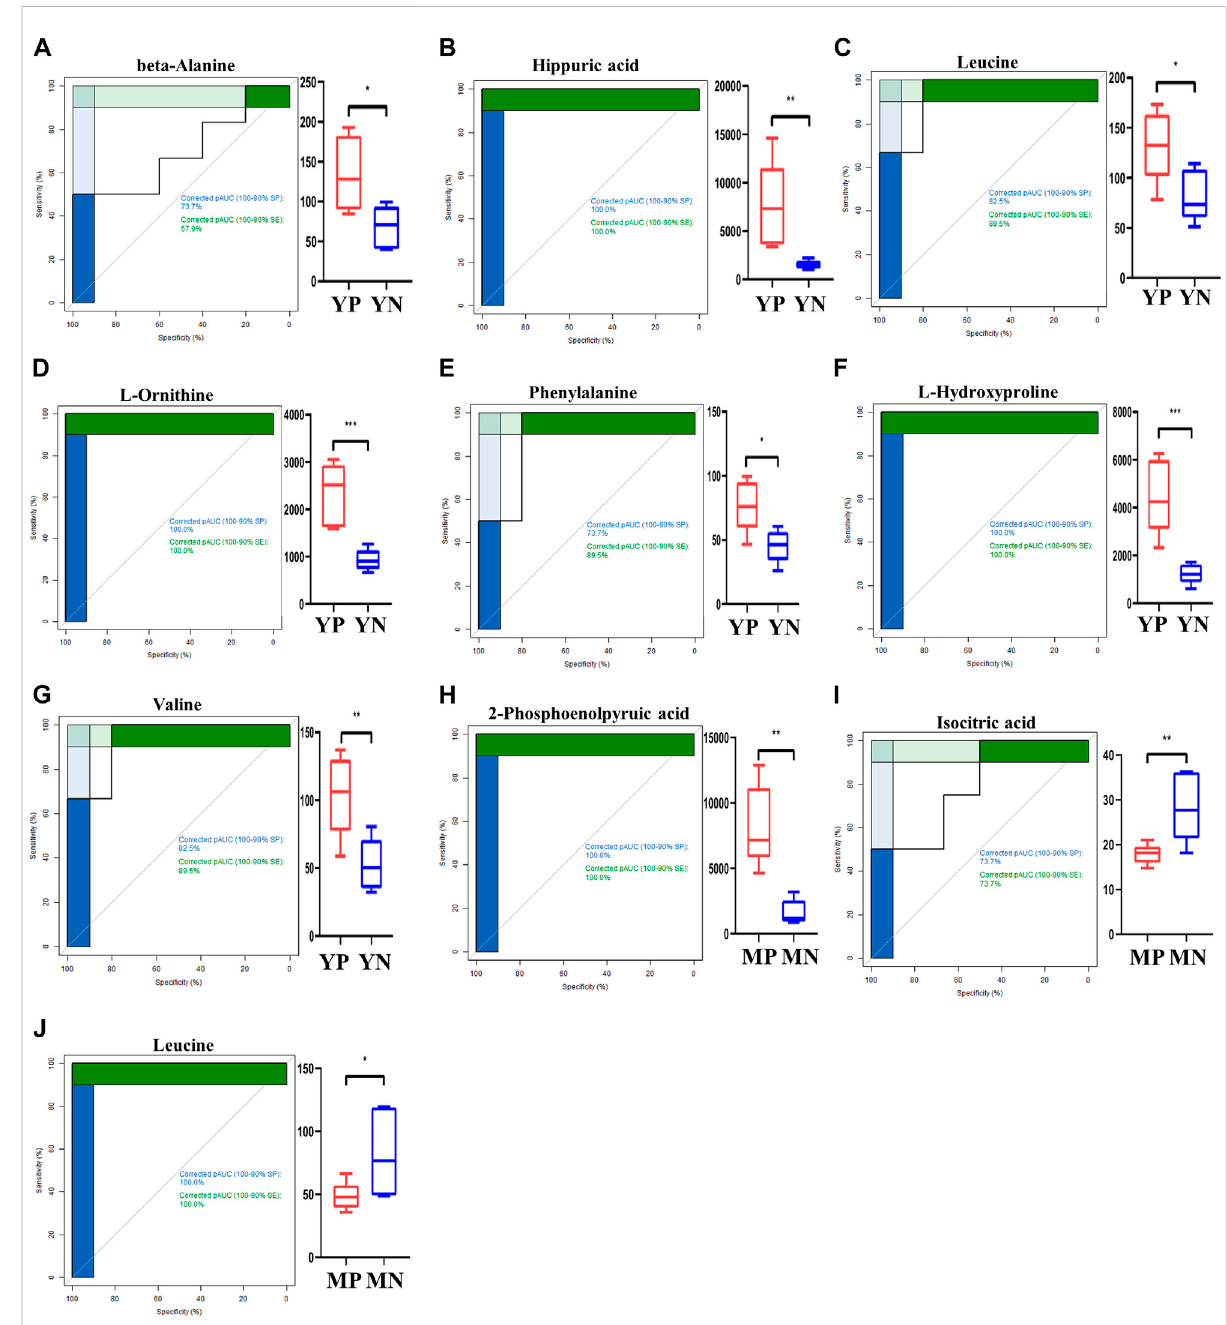
FIGURE 3 ROC curves for exosomal metabolites (A – J) with an area under the ROC curve above 90% (left panel). The levels of shortlisted metabolites are displayasboxplots(rightpanel).ComparisonsareeitherbetweenyoungPCOS(YP)andyoungnormal(YN),ormiddleagePOCS(MP)andmiddleage normal